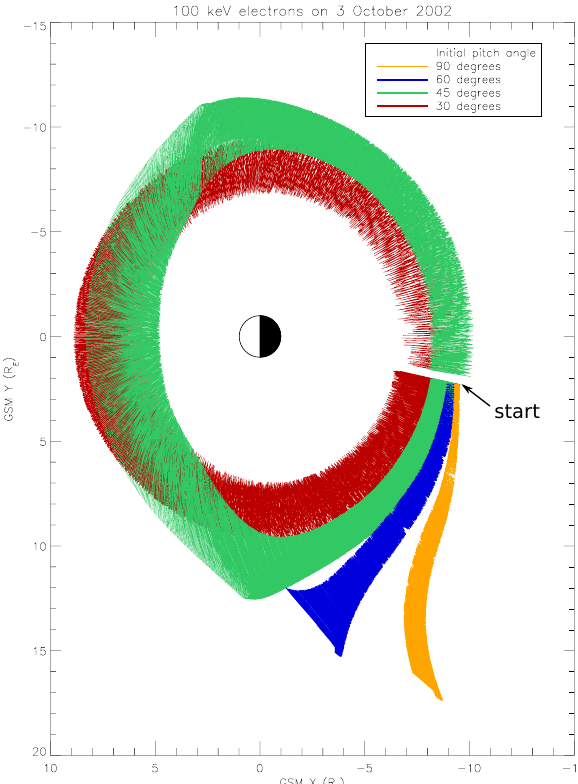
Fig. 8. The differential drift paths of electrons with four different pitch angles are shown. All simulations begin at the location of Po- lar at 05:00UT and trace backwards in time until the particle is lost or completes a drift orbit. The paths of the 60 ◦ and 90 ◦ pitch angle electrons are shortened due to contact with the model’s mag-